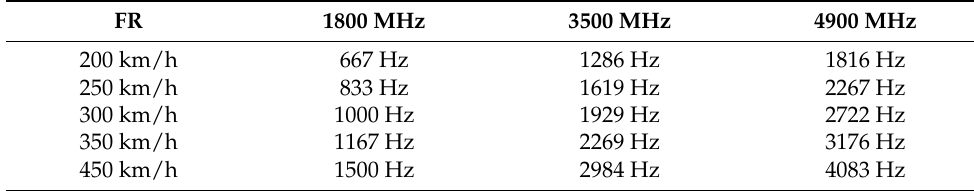
Table 2. The values of uplink Doppler